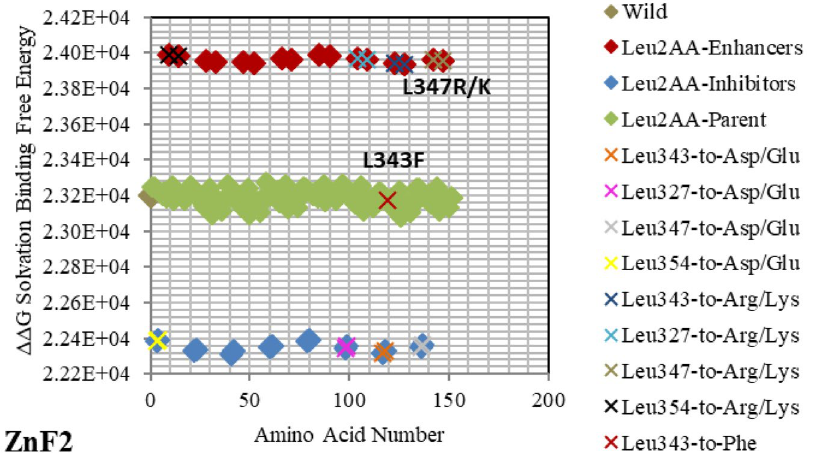
Figure 7. Electrostatic free energy differences of Leucine (Leu/L) within GATA3:DNA complex. Plot presents the solvated binding free energy calculations (in KJ/mol) of GATA3 Leu amino acid mutants in both of Chain-D and Chain-C.